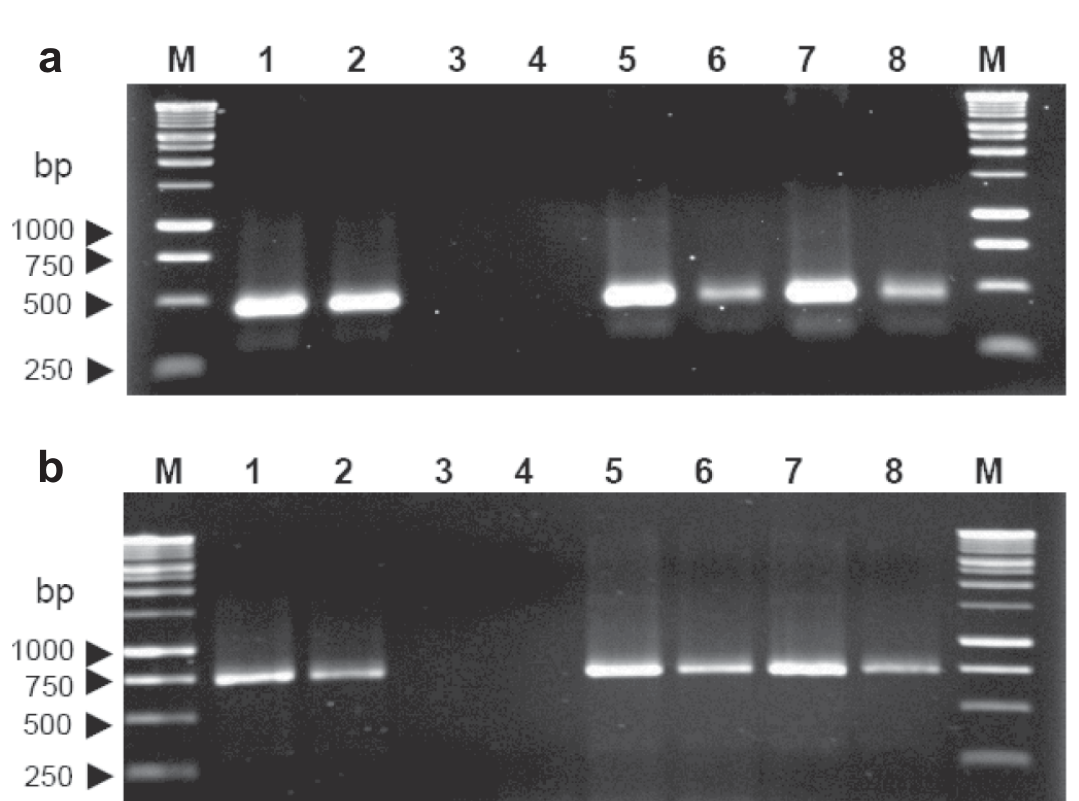
Fig. 3. PCR performed with primers specific to the TYLCSV isolate from Morocco, using cloned full-length genomic DNA of TYLCSV from Morocco (pTYLCSV-MO-1) and of TYLCV from the Dominican Republic (TYLCV-[DO]) as template. (a) with primer pair PTYMv1887-PTYMc2322 (462 bp product); (b) with primer pair PTYMv1887- PTYMc2596 (734 pb product). Lane 1, pTYLCSV-MO-1 (1 ng DNA); lane 2, pTYLCSV-MO-1 (0.1 ng); lane 3, TYLCV- [DO] (0.1 ng); lane 4, TYLCV-[DO] (0.01 ng); lane 5, mixture of pTYLCSV-MO-1 (1 ng) and TYLCV-[DO] (0.01 ng); lane 6 mixture of pTYLCSV-MO-1 (0.1 ng) and TYLCV-[DO] (0.01 ng); lane 7, mixture of pTYLCSV-MO-1 (1 ng) and TYLCV-[DO] (0. 1 ng); lane 8, mixture of pTYLCSV-MO-1 (0.1 ng) and TYLCV-[DO] (0.1 ng); M, 1 Kbp ladder